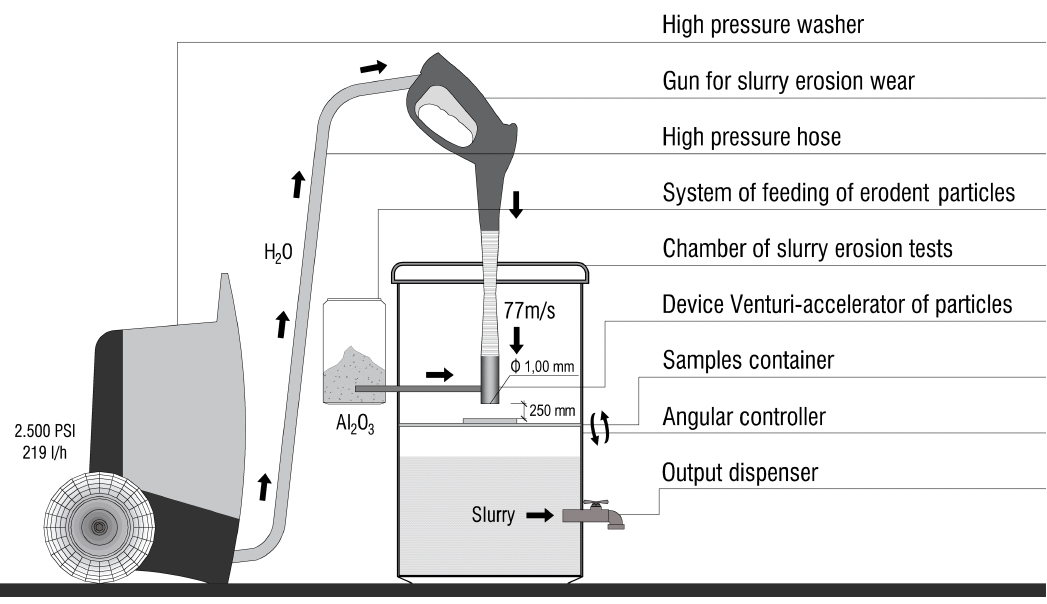
Figure 4. Schematic diagram of the jet slurry erosion